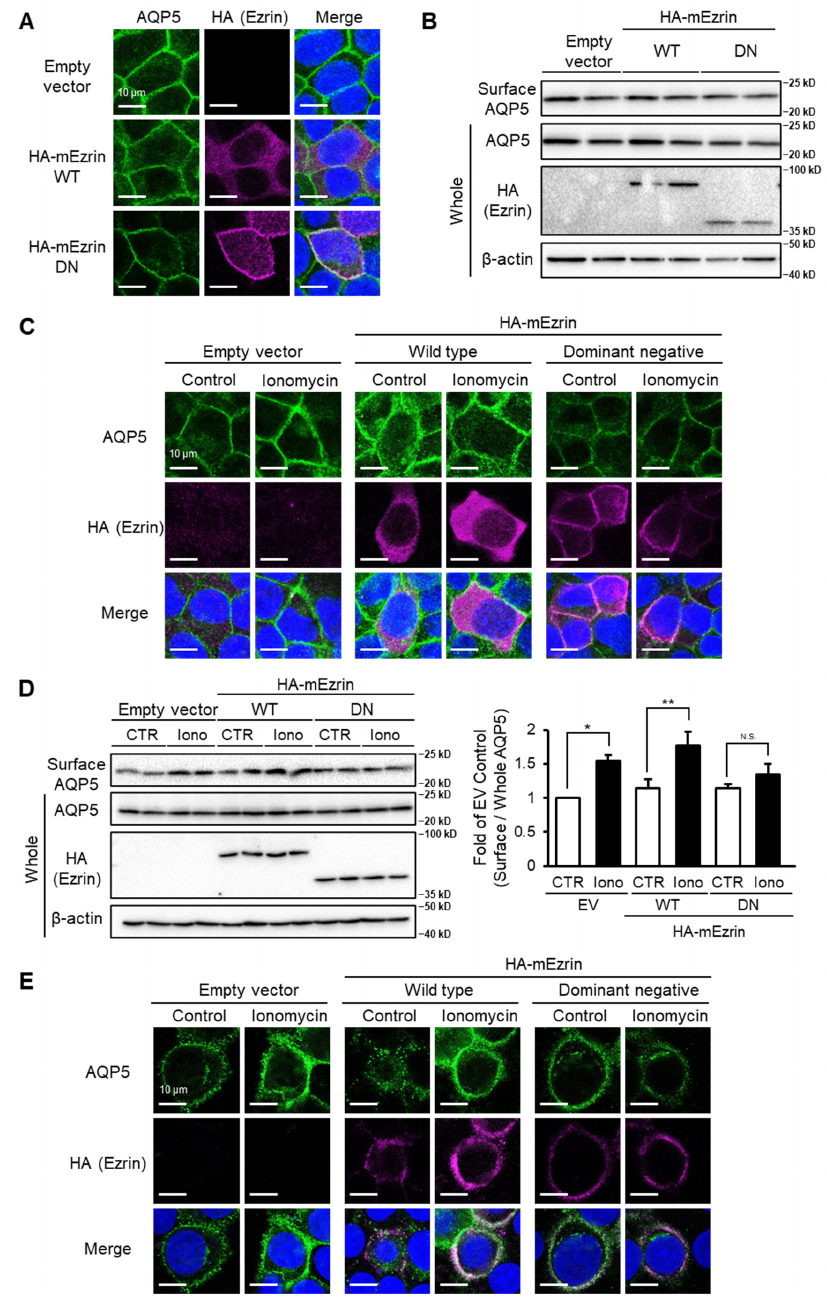
Figure 1. Ezrin-DN inhibits stimulation-dependent plasma membrane translocation of AQP5. MLE-12 cells were transfected with wildtype or dominant negative (lacking actin-binding domain) ezrin. Subcellular localization of AQP5 was analyzed by immunofluorescence ( A ), and the amount of cell surface AQP5 was assessed by Western blotting ( B ). Cells were treated with ionomycin (1 µ M) for 15 min, after which cellular localization of AQP5 was analyzed by immunofluorescence ( C ) and the amount of cell surface AQP5 was assessed by cell surface biotinylation and Western blotting ( D ). HSG cells were transfected with wildtype or dominant negative ezrin, after which cells were treated with ionomycin (1 µ M) for 15 min. Subcellular localization of AQP5 was analyzed by immunofluorescence ( E ). Blue staining in merge image indicates DAPI (nuclei). Data represent the mean ± S.E. ( n = 3–6). * p < 0.05 and ** p <